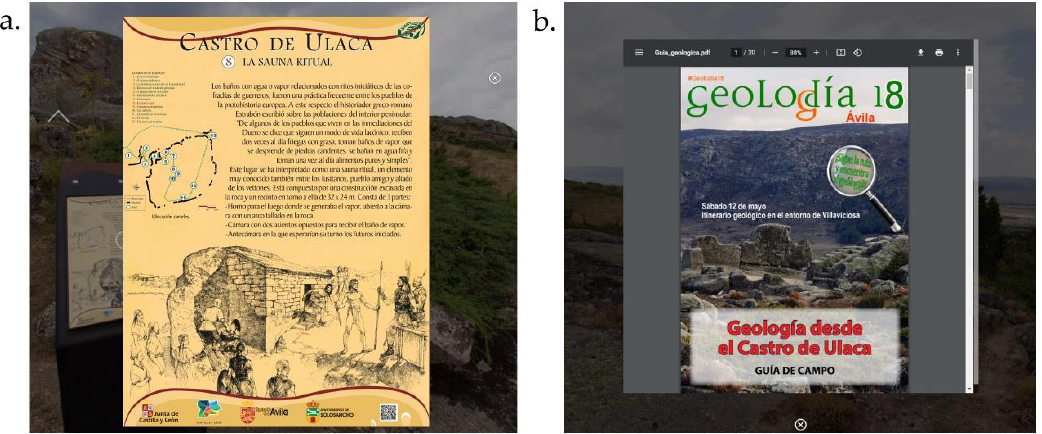
Figure 9. Virtual tour: ( a ). Appearance when the user clicks on a hotspot with information related to the explanatory panels; ( b ). Appearance when the user clicks on the hotspot devoted to the geological guide (navigation menu).